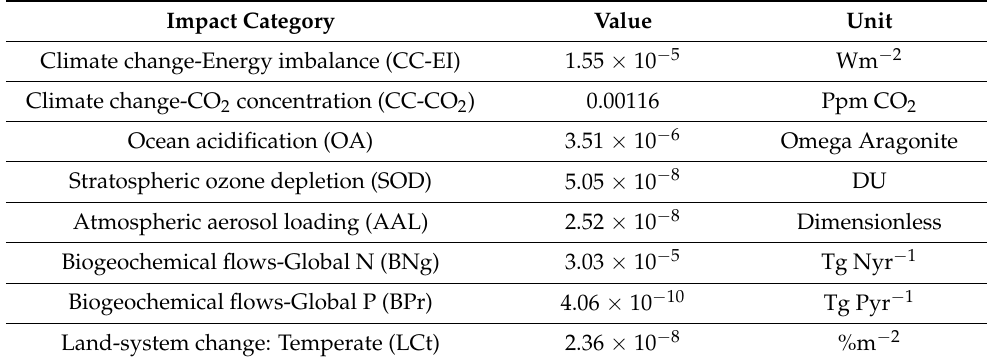
Table 2. Overview of relative environmental impacts for the wood-based panel value